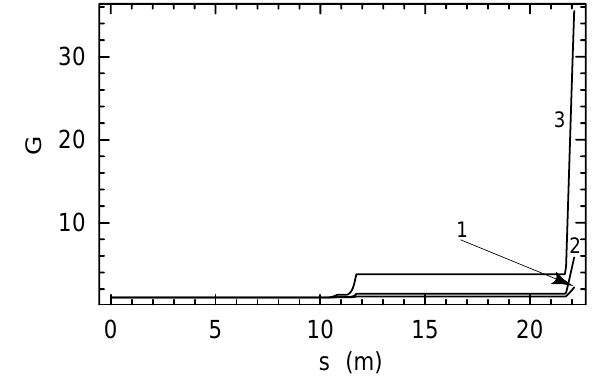
FIG. 7. Amplification factor G (cid:2) s (cid:3) for e (cid:1) 0 , s p (cid:1) 3.0 3 10 2 6 for three values of l : ( 1 ) l (cid:1) 50 m m, ( 2 ) l (cid:1) 20 m m, and ( 3 ) l (cid:1) 5 m